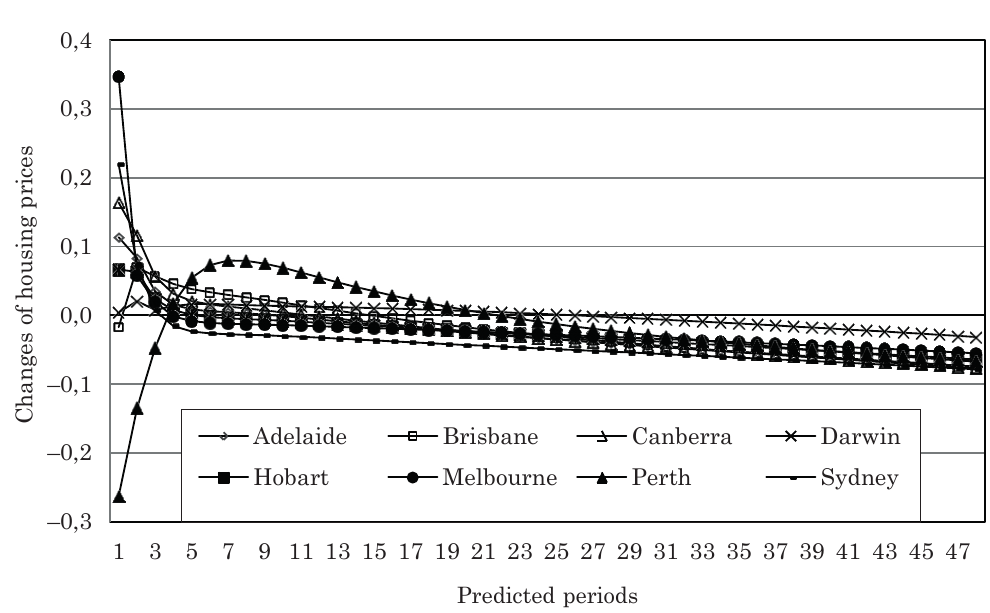
Figure 3. Movements of house price levels caused by a shock in